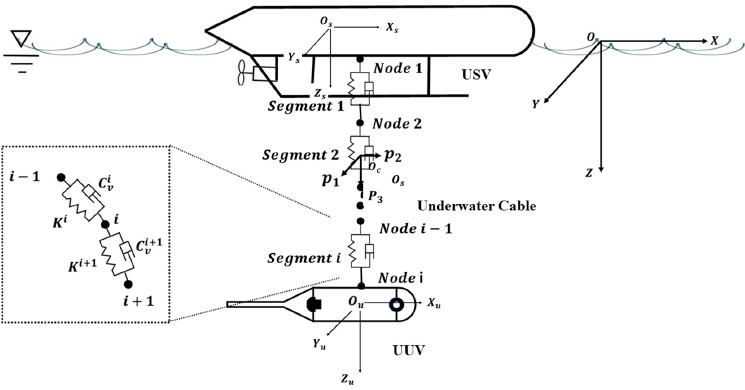
Figure 2. Schematic of the Unmanned Ocean Platform.